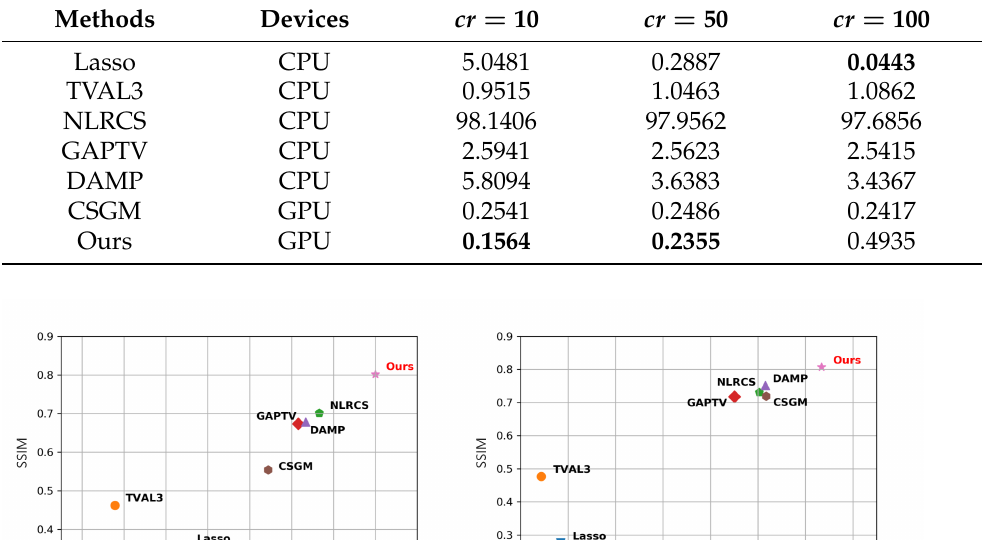
Table 2. The average runtime (seconds) for each method with the variety of compression rates. Bold indicates the best result.